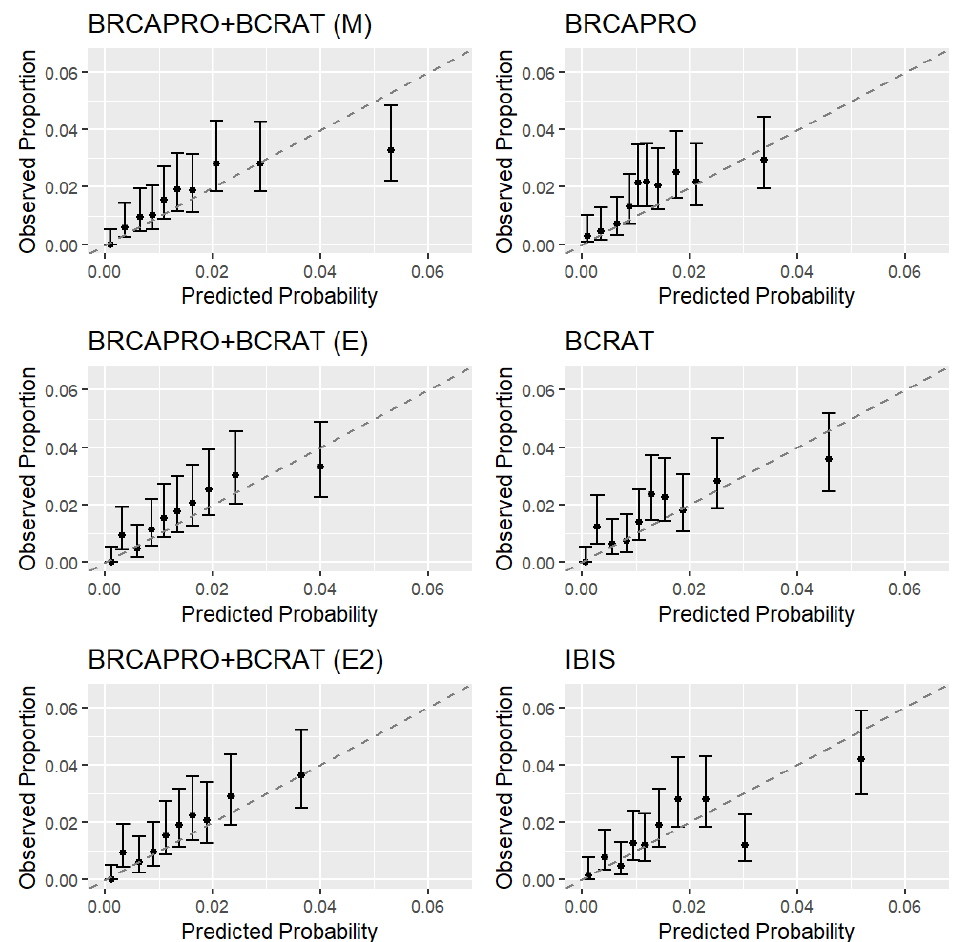
Figure 4. Calibration plots by decile of risk for five-year predictions in CGN. For each model, we grouped individuals by decile of risk and plotted the observed proportion of women who developed cancer (with 95% Wilson CI) versus predicted probability (sum of risk predictions) within each decile. In computing the observed proportions, the inverse probabilities of the censoring weights were used to account for